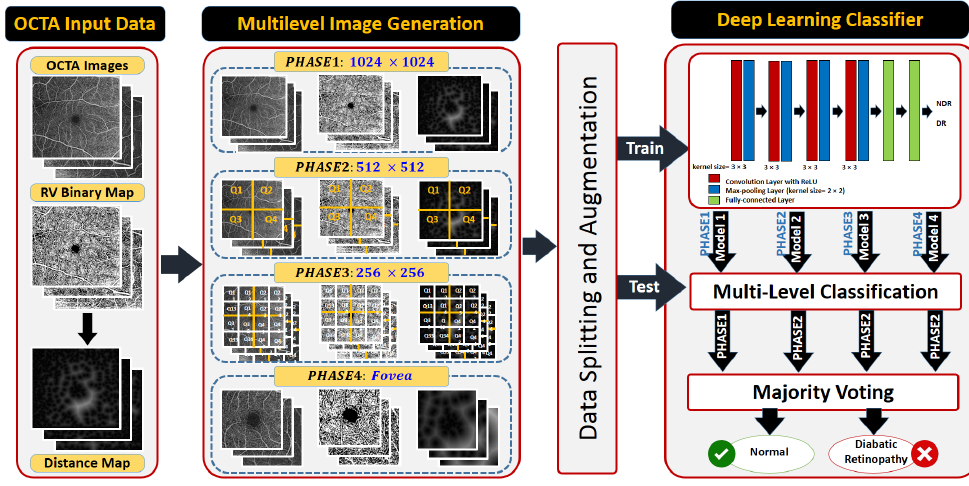
Figure 1. A schematic diagram of deep learning-based optical coherence tomography angiography